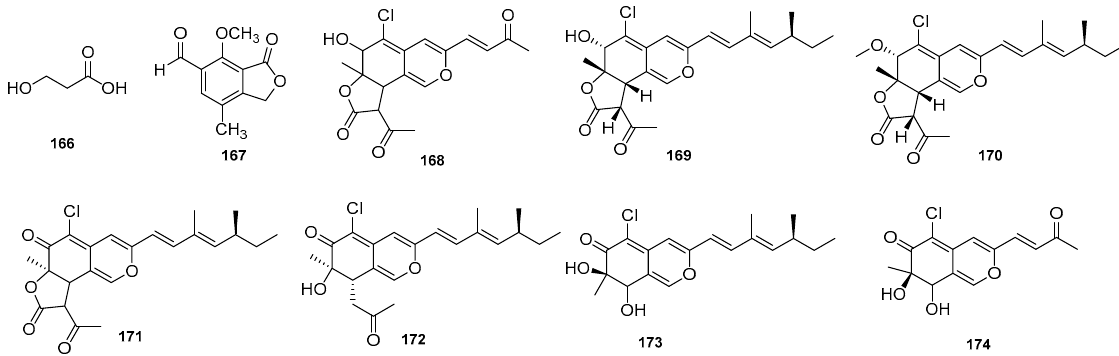
Figure 6. Chemical structures of compounds 166 – 174 of marine origin.